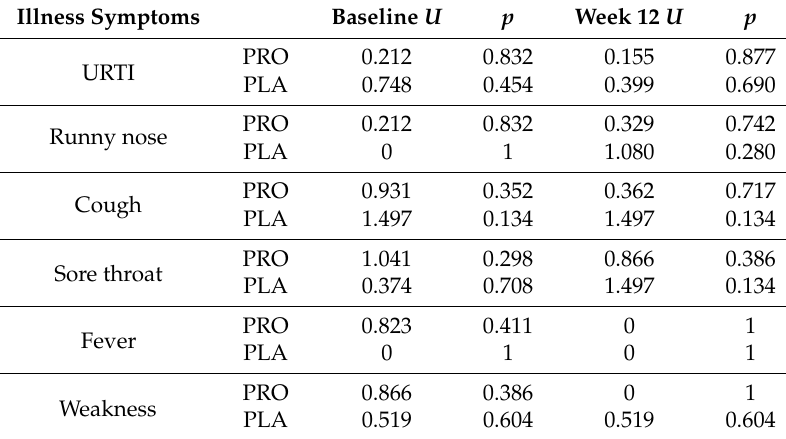
Table 5. Interaction between gender and illness symptoms in 29 athletes before and after 12 weeks of treatment either supplemented with probiotics (PRO) or placebo